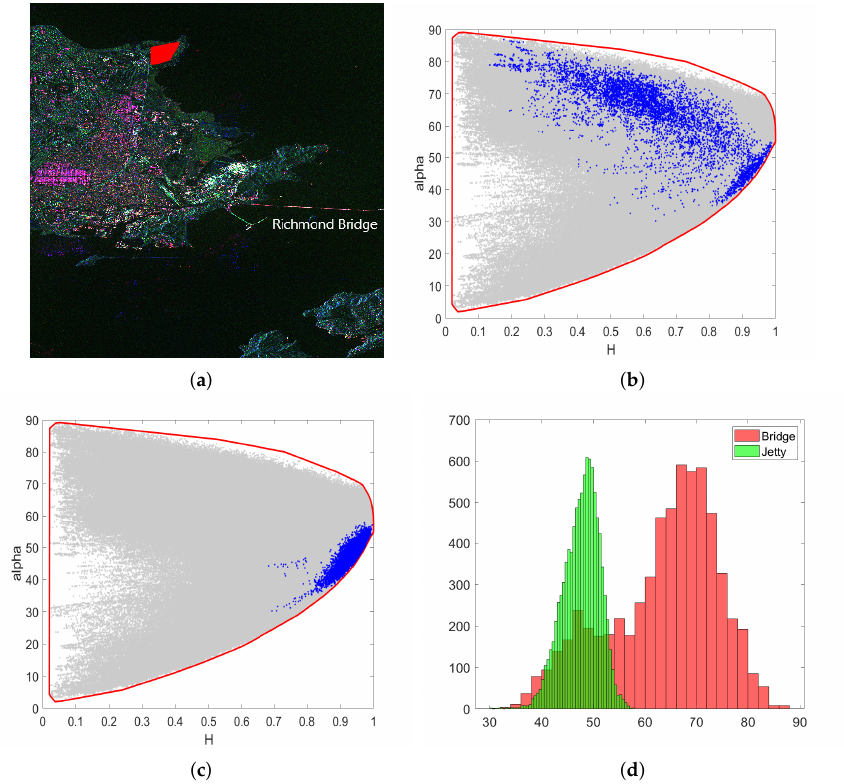
Figure 2. Distribution of polarization entropy and scattering angle of the sea-crossing Richmond Bridge in the San Francisco region from TerraSAR-X. ( a ) The Pauli pseudo-color image of the sample data, where the region marked in red is a selected coastal natural raised terrain. ( b ) Results of the sea-crossing bridge, where the gray region is the distribution of the whole image, the red line is the contour line of the overall distribution, and the blue points are the scatter distribution of the pixels in the bridge region. ( c ) Results of the raised terrain region along the coast. ( d ) Comparison of the scattering angle histograms of the two regions, where the red area is the bridge region and the green area is the coastal raised terrain